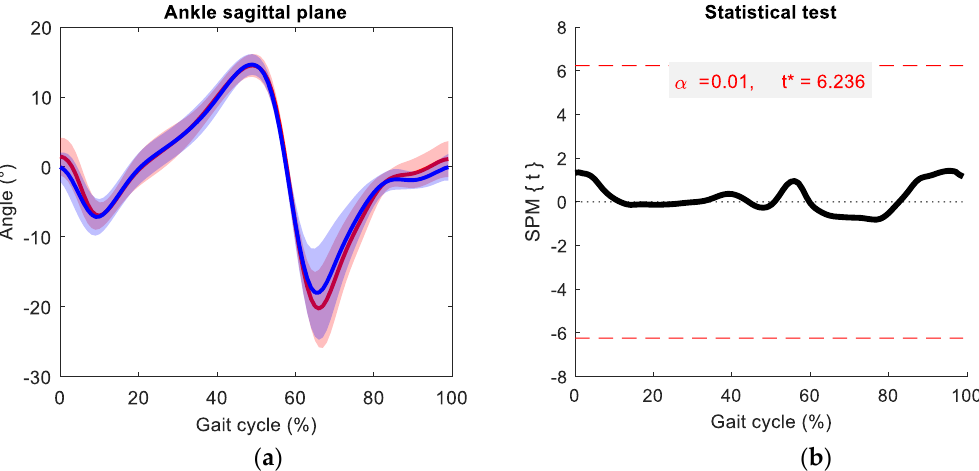
Figure 5. ( a ) Mean sagittal ankle angle during gait cycle from heel strike to heel strike with (red) and without (blue) exosuit, and ( b ) statistical 1D SPM test; * critical t-value.